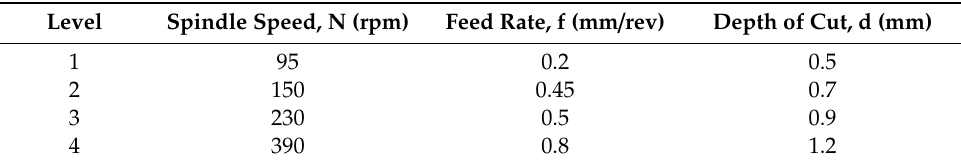
Table 1. Parameters and their levels.